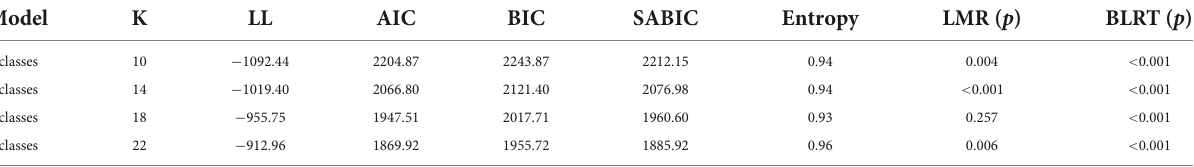
TABLE 2 Statistical criteria associated with latent class